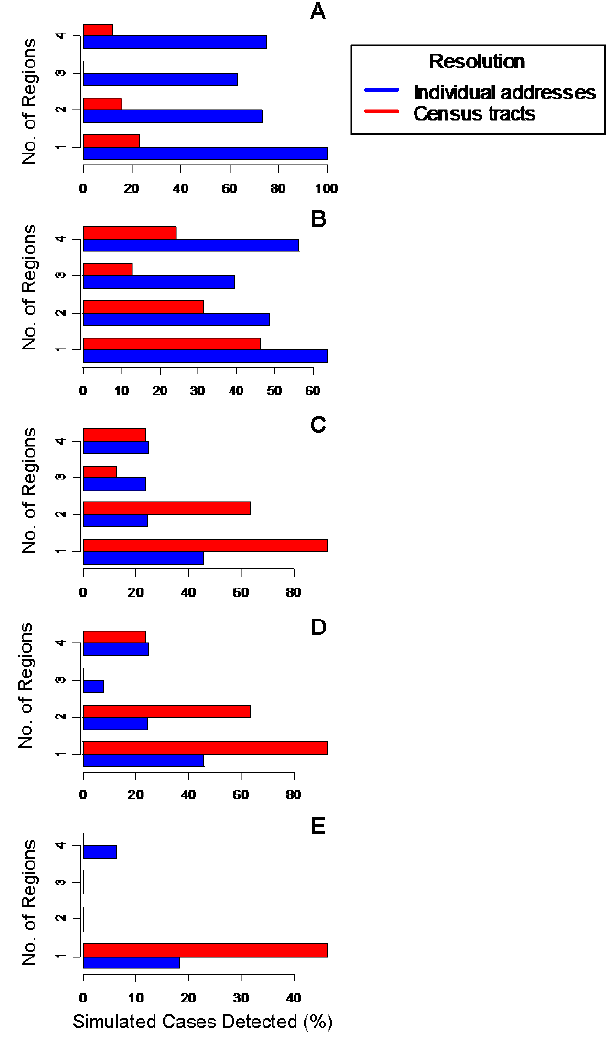
Figure 4. Average detection sensitivity of the method applied to simulated outbreaks. Cases were simulated in one to four adjacent census tracts using a fixed time window with increasing spatial window. The percentage of outbreaks detected are reported using individual addresses (blue bars) and census tract centroids (red bars) for spatial window sizes of (A) 0.02 km, (B) 0.1 km, (C) 0.2 km, (D) 0.5 km, and (E) 1 km, where in each case, simulated outbreaks were added to increasing number of census tracts (1 to 4) . This simulation was conducted on 12 separate geographic regions of 0.2 km in range and the average detection percentage was calculated. For each plot, the horizontal axis is scaled to the maximum detection sensitivity percentage to better visualize the primary comparison between individual addresses and census tract.